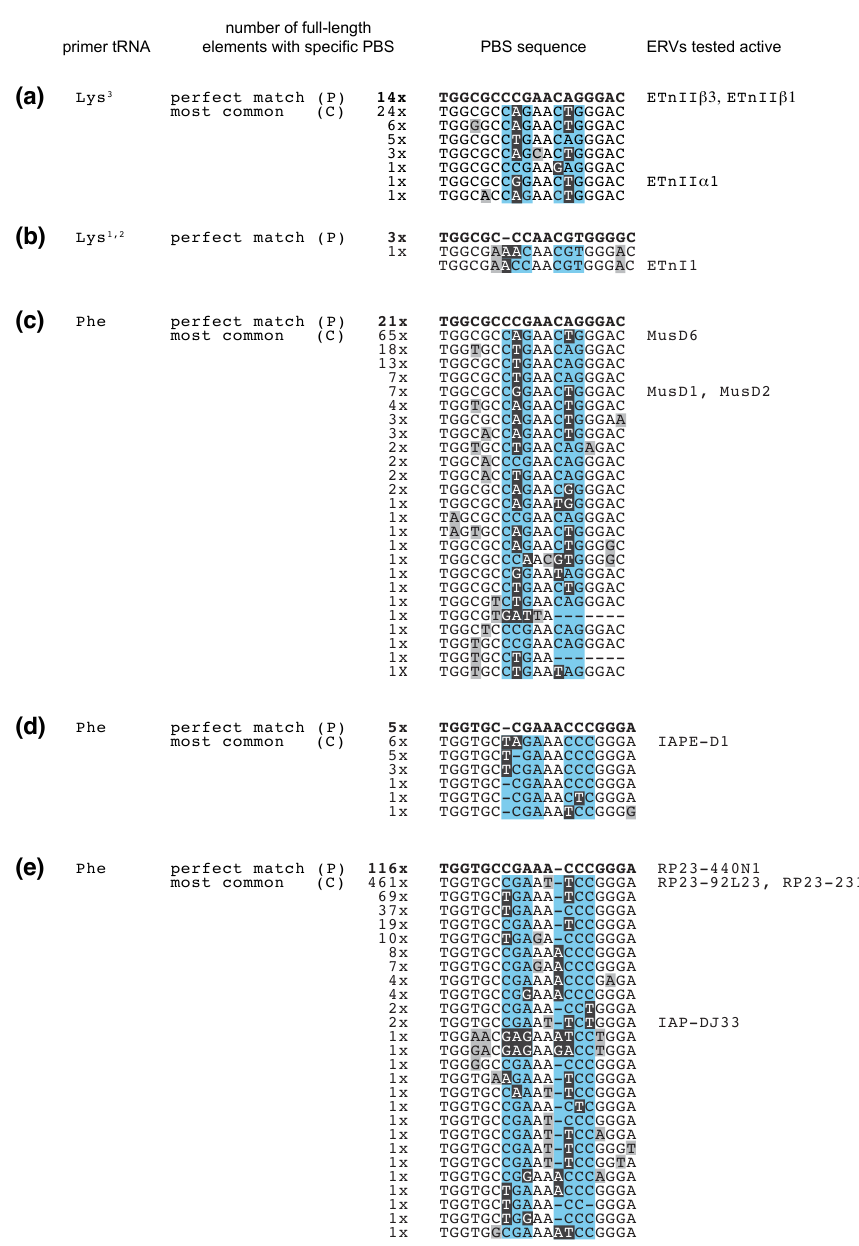
TGGTGCCGAAT-TCCGGGA RP23-92L23, RP23-231P12 69x